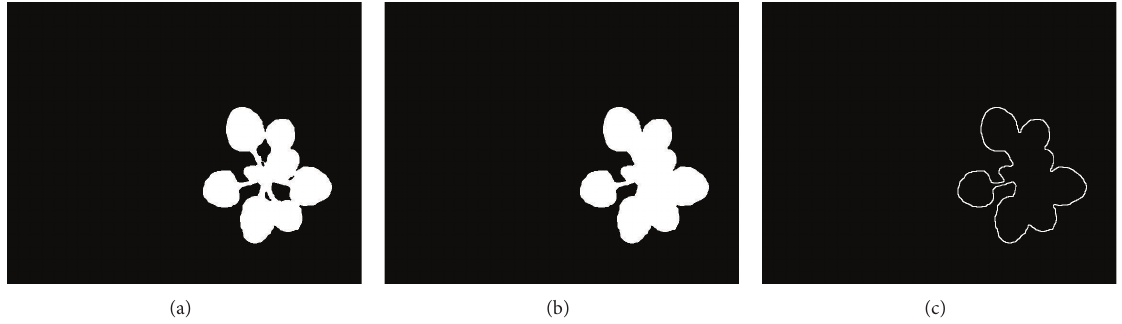
Figure 2: Image segmentation. (a) Binary image of segmentation result. (b) Image after filling the holes. (c) Outer contour of the